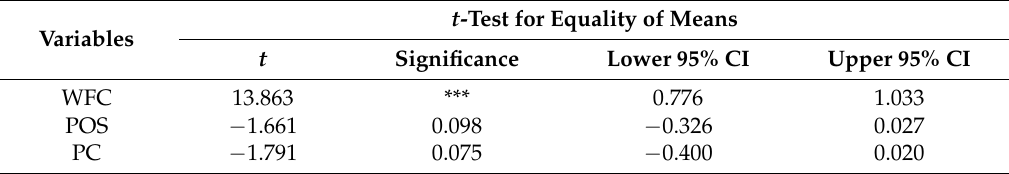
Table 6. The results of independent samples t